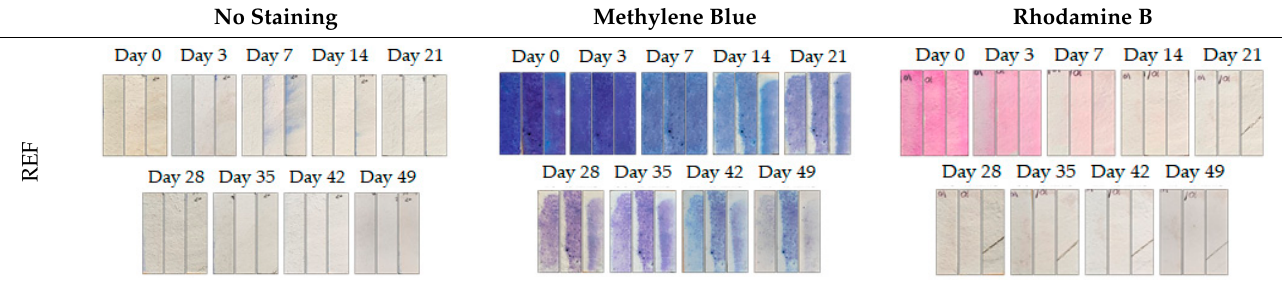
Table 6. Visual aspect of cement tiles, before and after exposure to the urban environment, per different stains and TiO 2 contents.